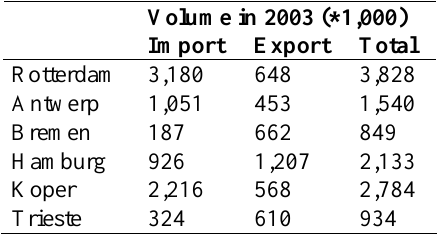
Table 1. The volumes of the six largest ports for Austrian cargo